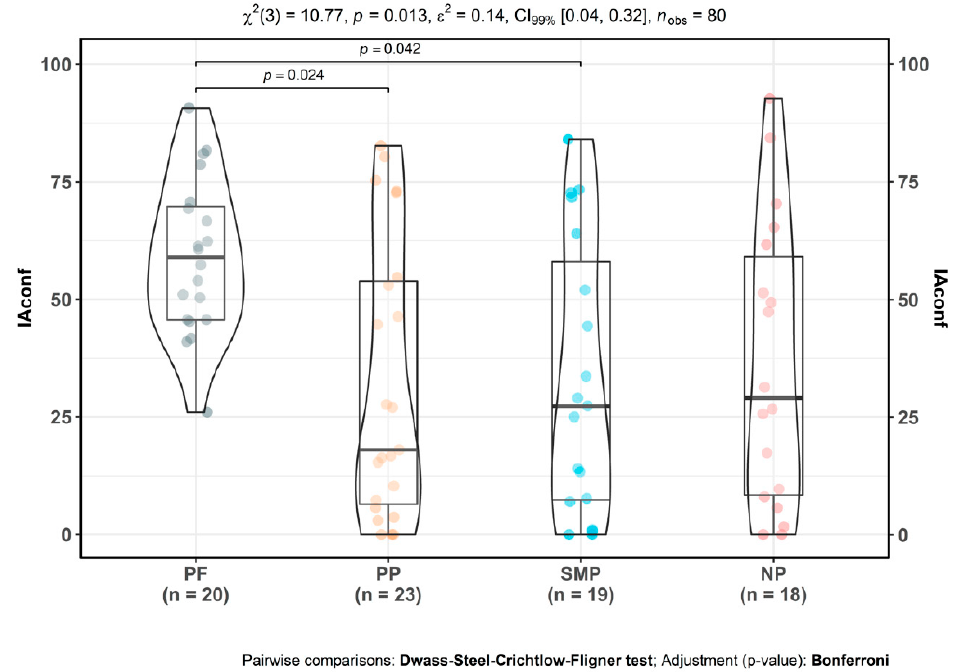
Figure 2. Interoceptive confidence (IAconf) alterations in CP. PF: pain-free participants. PP: primary CP participants, SMP: secondary musculoskeletal CP participants, NP: neuropathic CP participants. Mean values: PF µ = 59.05, CI 95% (51.36, 66.74), PP µ = 31.9, CI 95% (19.22, 44.58), SMP µ = 32.67, CI 95% (18.68, 44.66), NP µ = 36.02, CI 95% (21, 51.04).